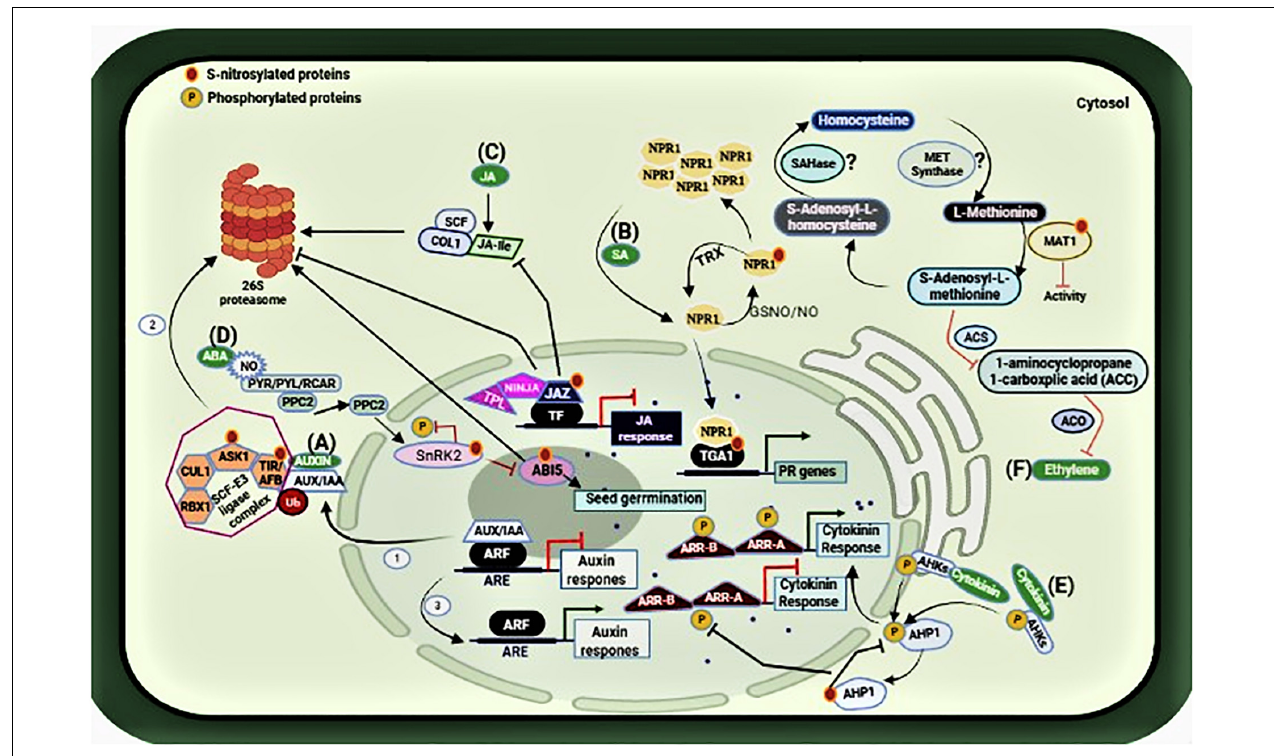
FIGURE 3 | Representation of the S-nitrosylated proteins involved in the hormonal network. (A) S-nitrosylation of ASK1 and TIR1 lead to the proteolytic degradation of AUX/IAA, thus initiating auxin response (steps 1–3). (B) S-nitrosylation/glutathionylation of NPR1leads to its oligomerization while S-nitrosylation of TGA1 promotes its interaction with NPR1 enabling the expression of PR genes. (C) S-nitrosylation prevents the interaction between JAZ1 repressor proteins and COI1, which is a subunit of the SCF ubiquitin E3 ligase complex for its proteasomal degradation. Thus, allowing JAZ1 to recruit its co-repressors NINJA and TPL to repress JA signaling. (D) S-nitrosylation of ABI5 also leads to its proteasomal degradation, thus promoting seed germination in the presence of NO. (E) S-nitrosylation of AHP1 inhibits its phosphorylation, compromising cytokinin response. (F) S-nitrosylation of MAT1 suppresses the activity of 1-aminocyclopropane1-carboxplic acid (ACC) synthesis and ACC oxidase, thereby affecting the synthesis of ethylene Moreover, S-nitrosylation of SAHase and MET synthase are still under investigation (shown with question marks). Figure made in BioRender.com.